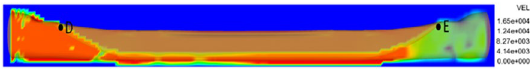
Figure 35 Distribution of fluid velocity measurement points at 0.28 s